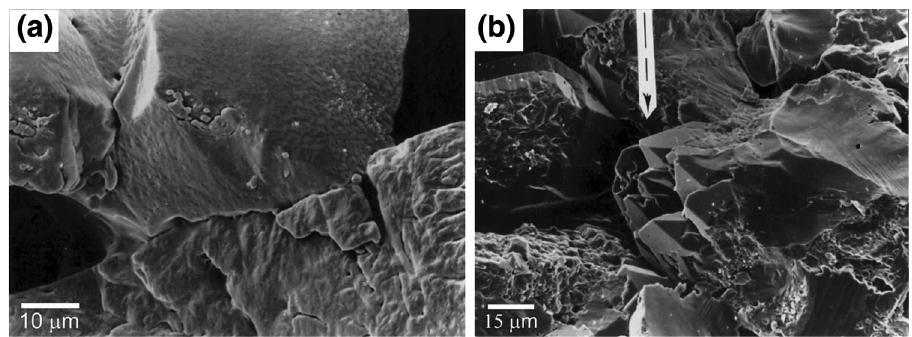
Figure 2. ( a ) Characteristic grain contact truncation microstructure in wet-compacted sample QC13 (T = 350 °C). Note that only one of the two grains in contact appears to have undergone dissolution. This feature is observed at nearly all the truncated/indented grains. Note also the absence of marginal dissolution features. ( b ) Euhedral quartz crystals in the pores of the wet-compacted sample QC13.